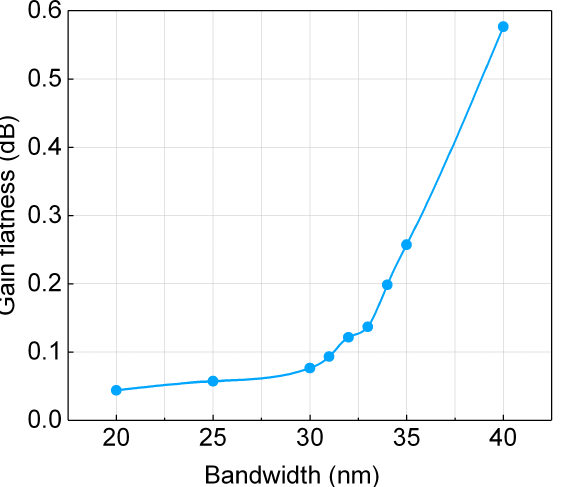
Figure 9. The result of different signal bandwidth with the pump band